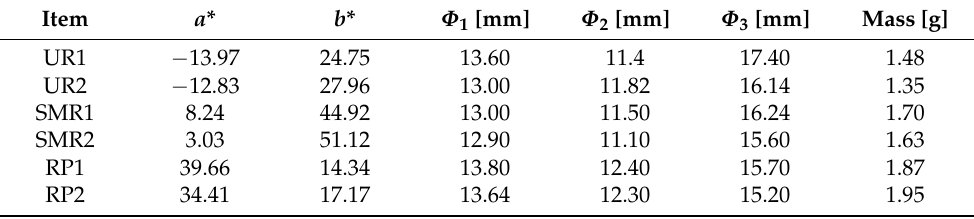
Table 2. Geometrical and physical properties of the coffee fruits selected as study